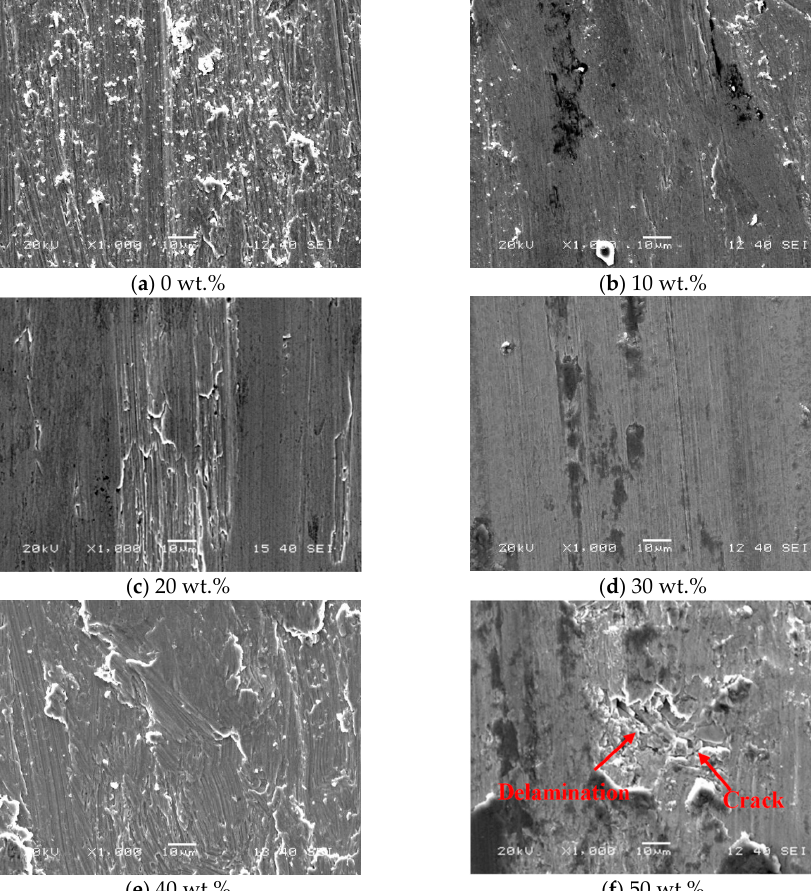
Figure 7. Microscopic morphologies of worn surfaces of laser cladded Ni45 + high-carbon ferrochrome